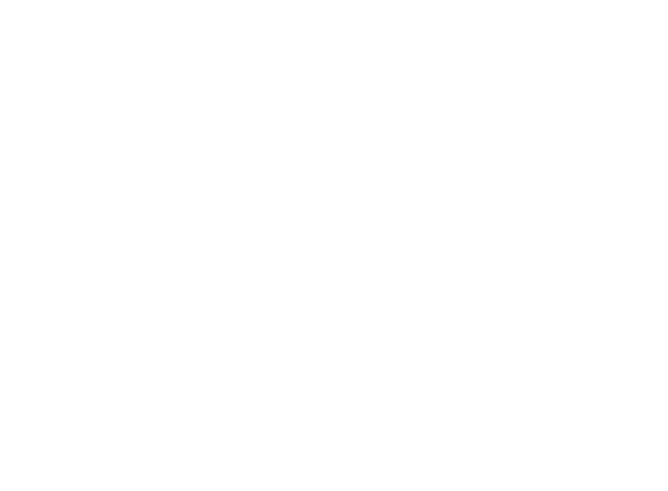
Figure 3. Spatial distribution of sea ice leads in the whole Arctic ( a , c , e ) and the Beaufort Sea ( b , d , f , g ) on 3 April 2013. Panels from top to bottom denote those in the AMSR2 data ( a,b ), HD ( c,d ), WHD ( e,f ), and QD ( g ) products. Only completely identified sea ice leads in the HD, WHD, and QD products are plotted. The blue boxes in the left panels denote the regions that are zoomed in.